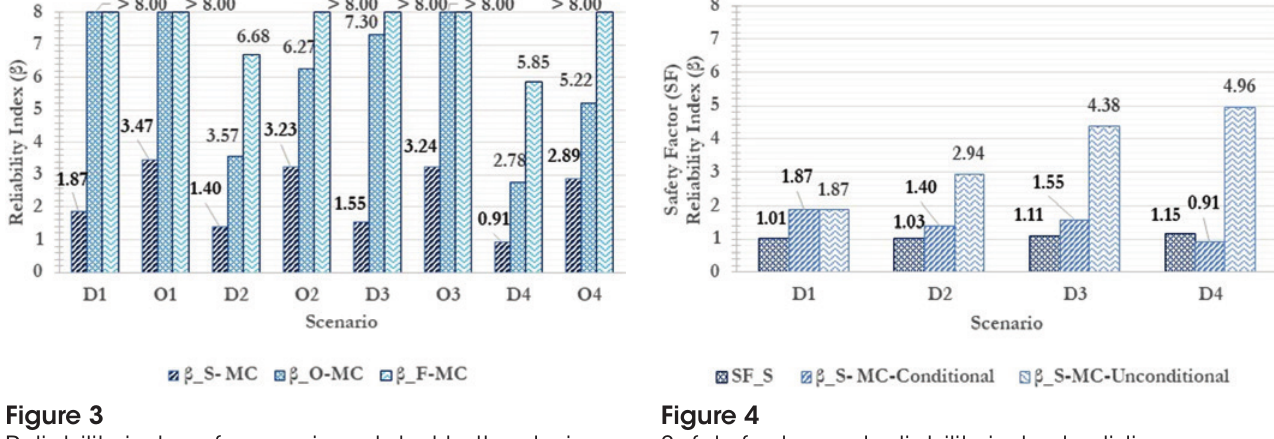
Safety factor and reliability index to sliding failure mode